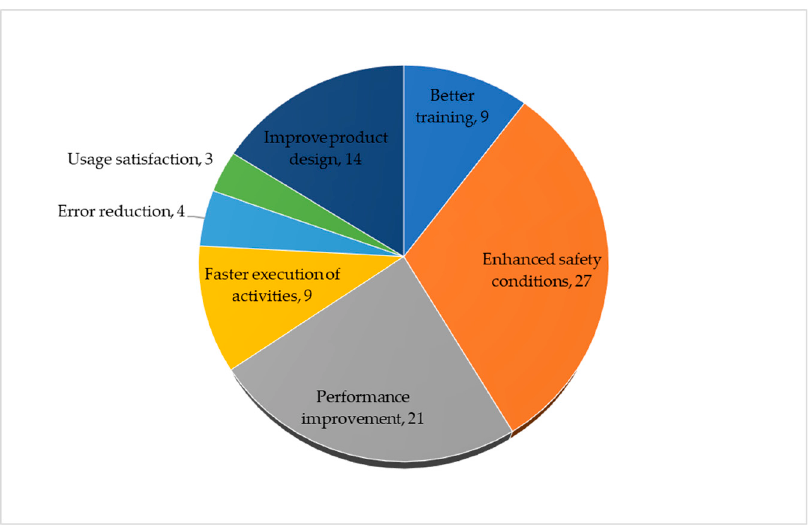
Figure 17. Distribution of benefits according to the selected articles.